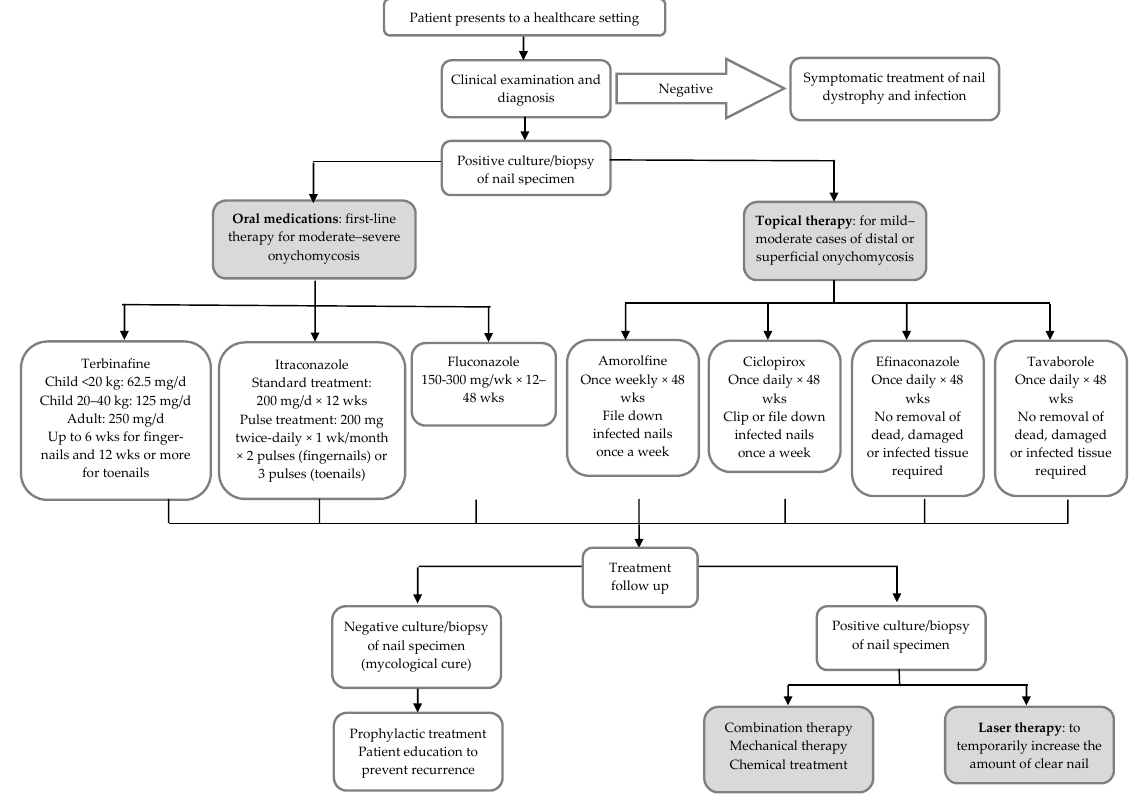
Figure 1. Onychomycosis treatment algorithm (modified from Thomas et al.